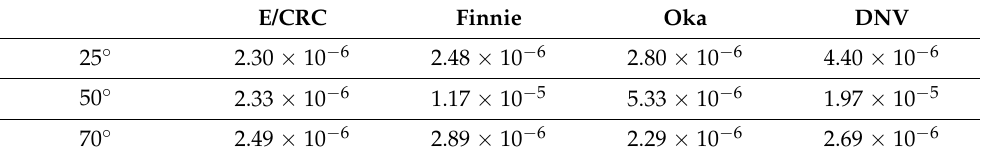
Figure 6. Comparison of four erosion models at different angles with Chen’s experimental results. Table 5. Difference of four erosion models at different angles with Chen’s experimental results.